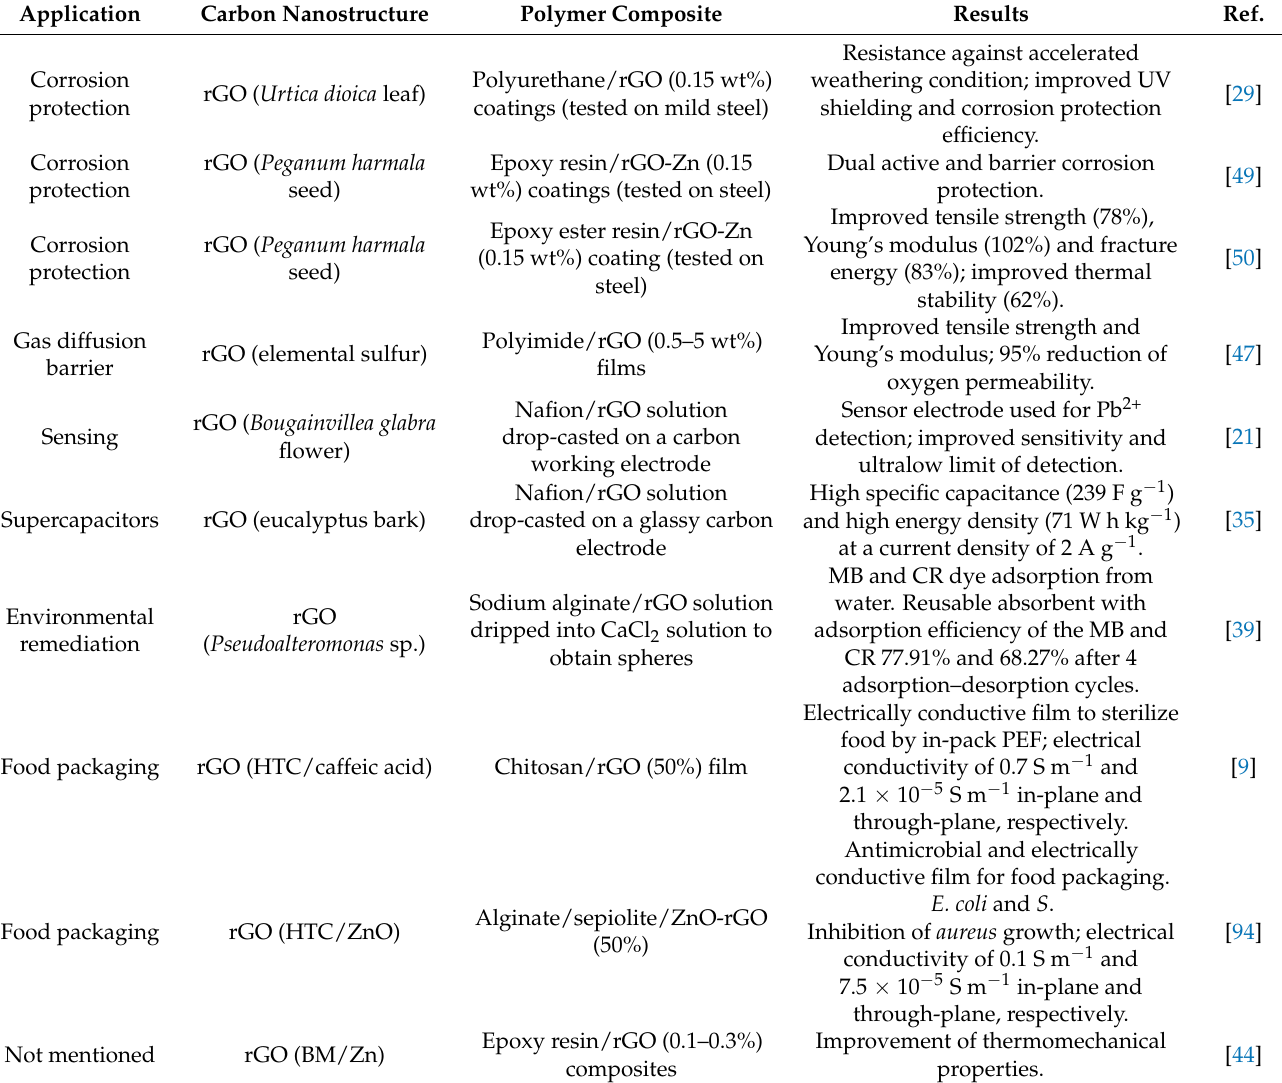
Table 2. Applications of polymer-based composites prepared using the green carbon nanostructures previously